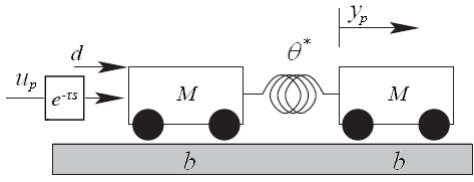
Figure 2. The two-carts benchmark